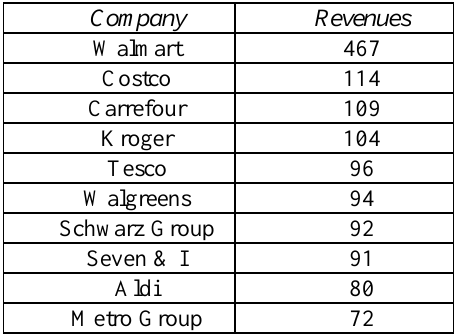
Table 1: The Main Large-Scale Retailers/Wholesalers in Global Markets. Revenues in 2015 (Billion €)